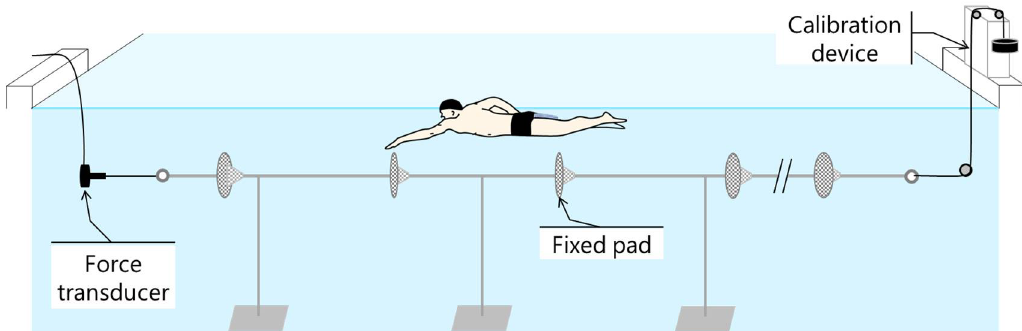
Figure 2. Top view of